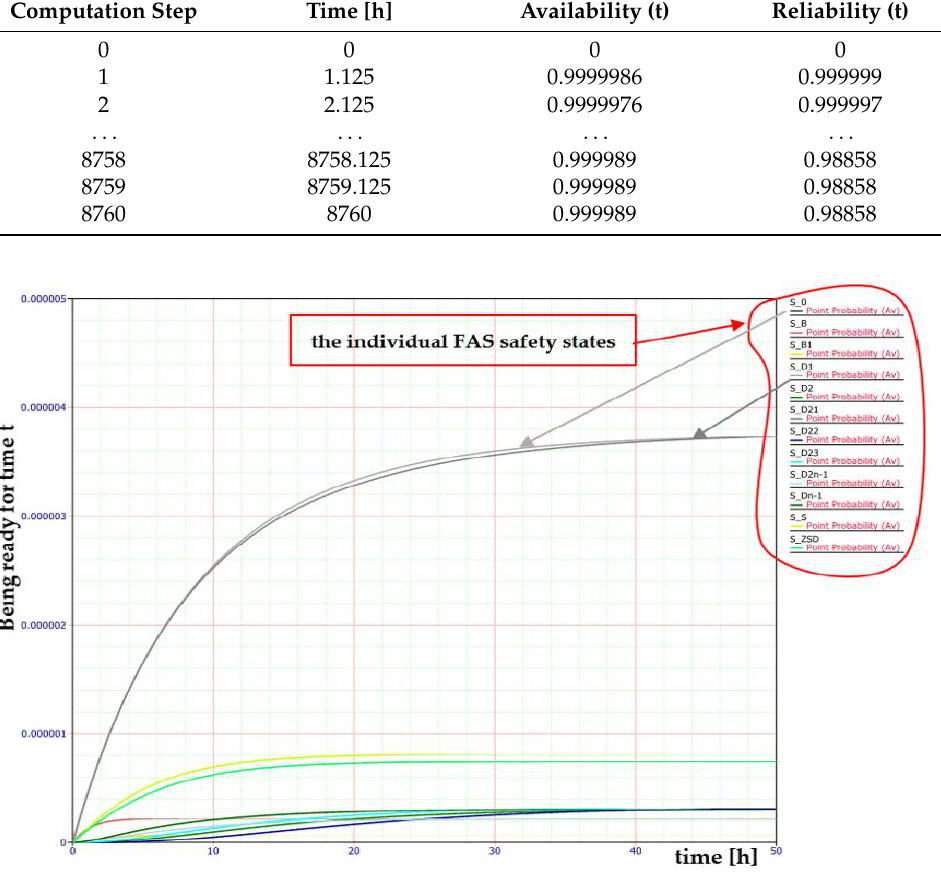
Figure 9. Graphs of availability over time for individual states of an FAS integrated with smoke exhaust and common fire detection [printout from the BlockSim software].